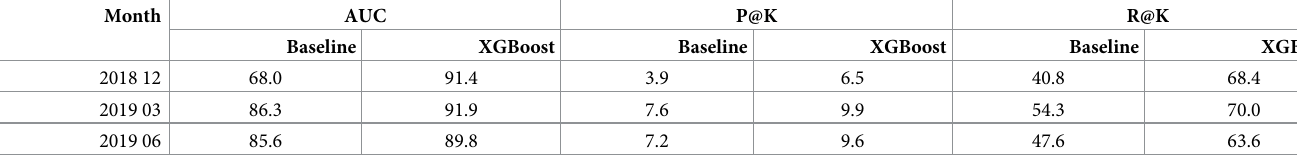
Table 5. Performance of the XGBoost model with respect to the baseline on 3 out-of-time